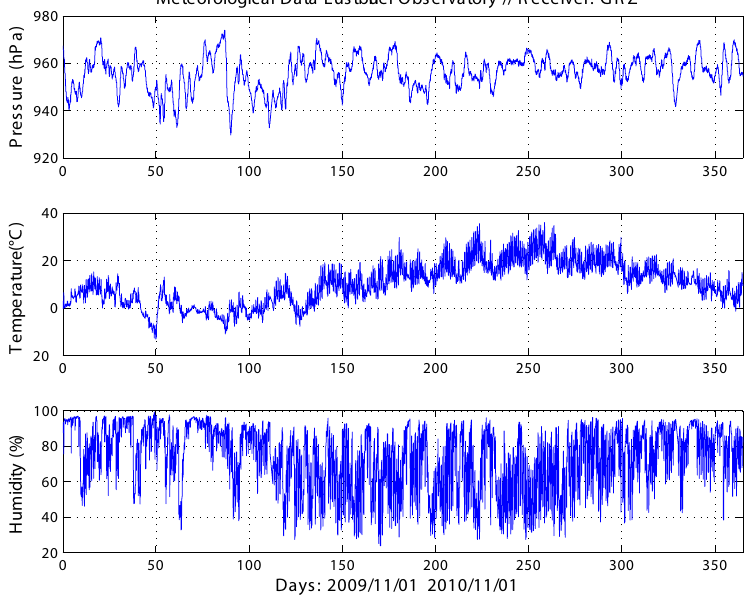
Fig. 5. Meteorological data for one year from a professional weather station located at Lustb¨uhel observatory a few km air-line distance from GRZ receiving station away. This facility delivers continuously (i) atmospheric pressure, (ii) temperature, and (iii) relative humidity data at a selectable 1 min or 10 min temporal